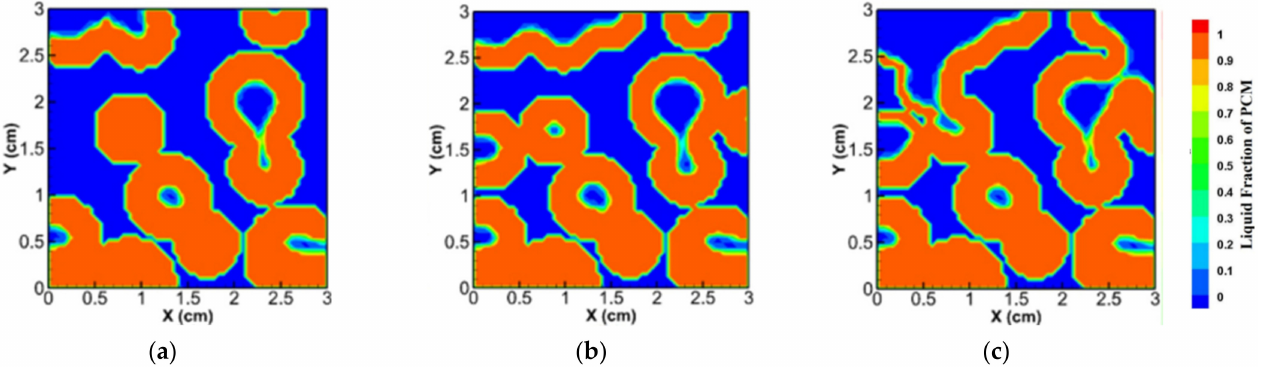
Figure 4. The melting front for different porosities of metal foams after 163 s performed by Parida et al. [81]; ( a ) 50% porosity, ( b ) 60% porosity, and ( c ) 70%